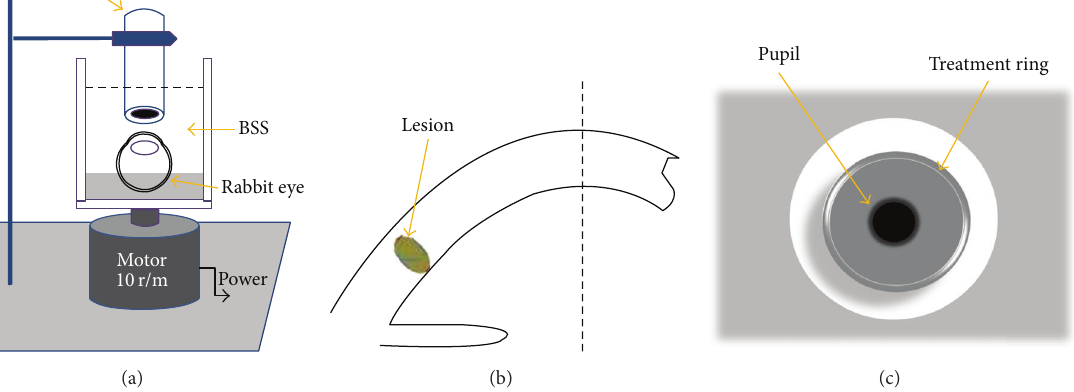
Figure 1: (a) Schematic diagram of HIFU keratoplasty transducer applied to an in vitro rabbit cornea cross section. (b) Cross-sectional view of the lesion of HIFU keratoplasty. (c) End view of the treatment